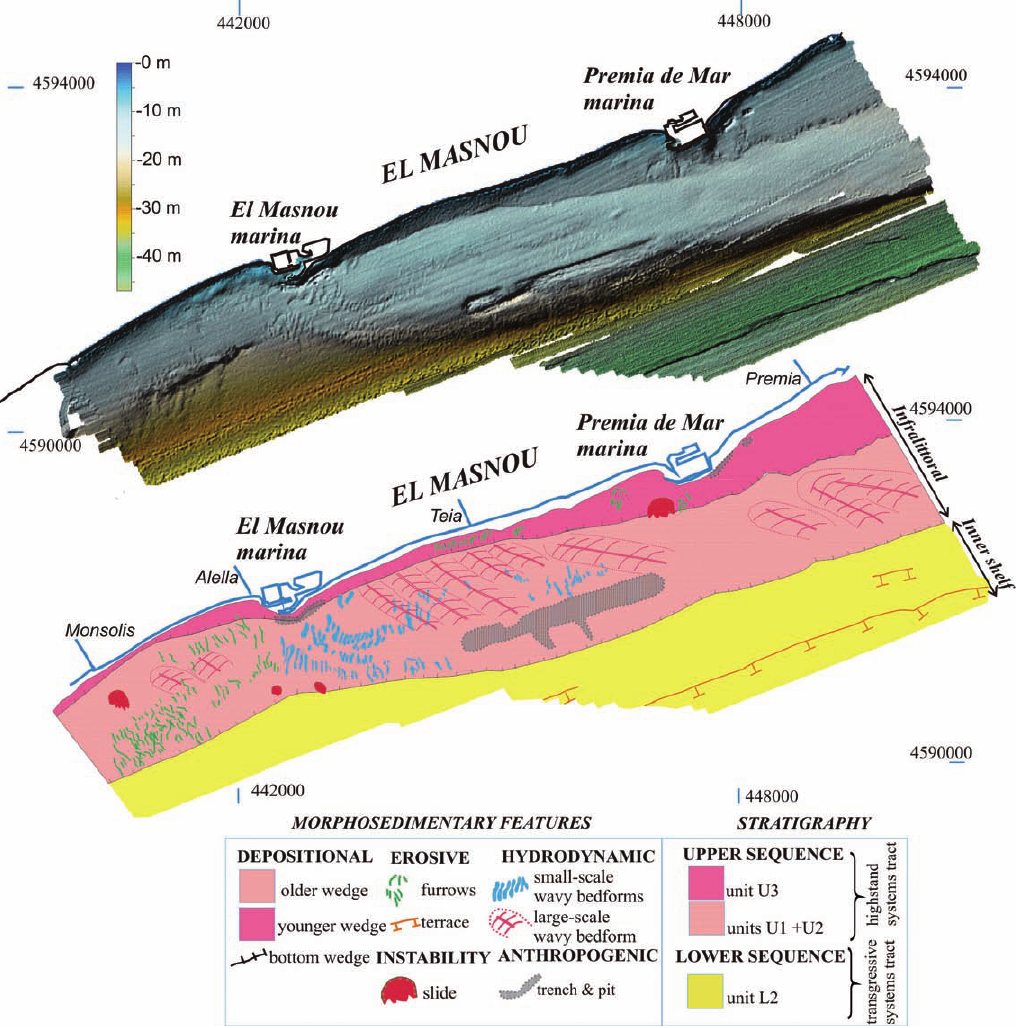
f ig . 2. – Multibeam shaded mean depth obtained in November 2006 (top) and line drawing (bottom) maps illustrating the main morpho- sedimentary features identified in the El Masnou infralittoral environment. Map illumination from NW. The line drawing map also shows the seafloor distribution of sediments forming the seismic sequence and